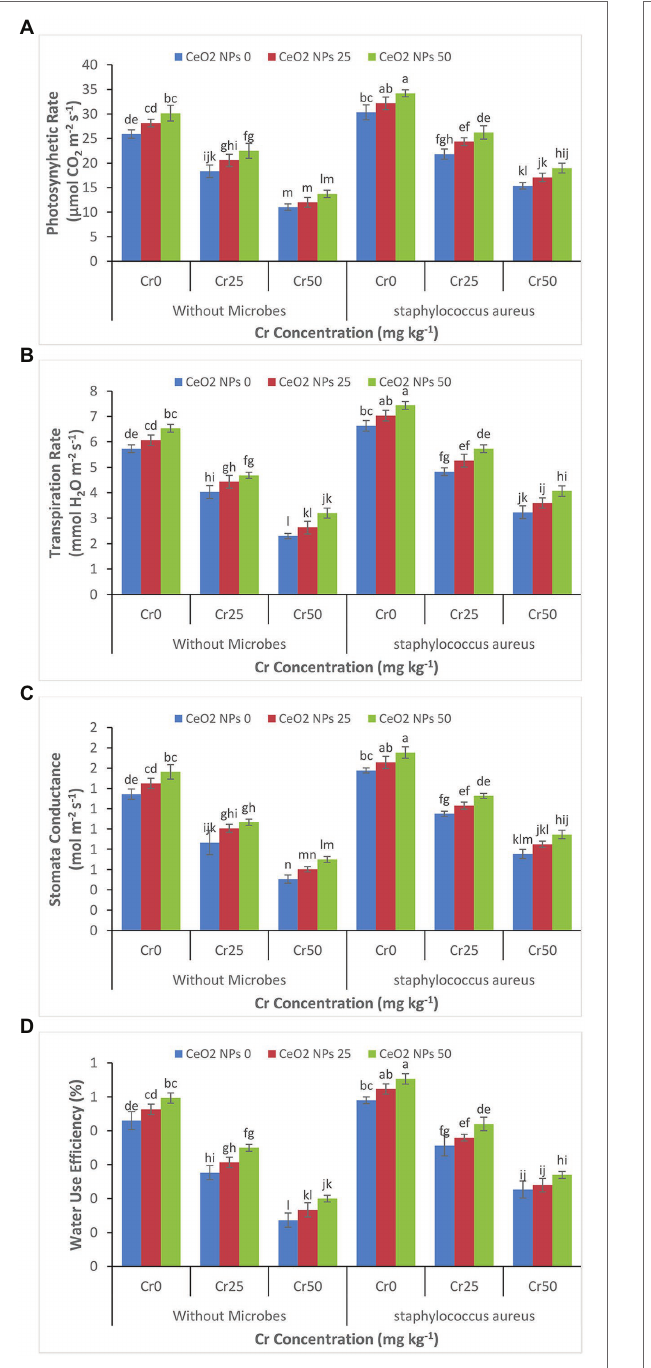
FIGURE 3 | (A–D) : Effect of CeO 2 NPs and Staphylococcus aureus on chlorophyll a (A) , chlorophyll b (B) , total chlorophyll (C) , and carotenoid content (D) in sunflower plant under Cr stress. The given values are means of three replications with standard deviation. The alphabets represent the significant/non-significant difference at p ≤